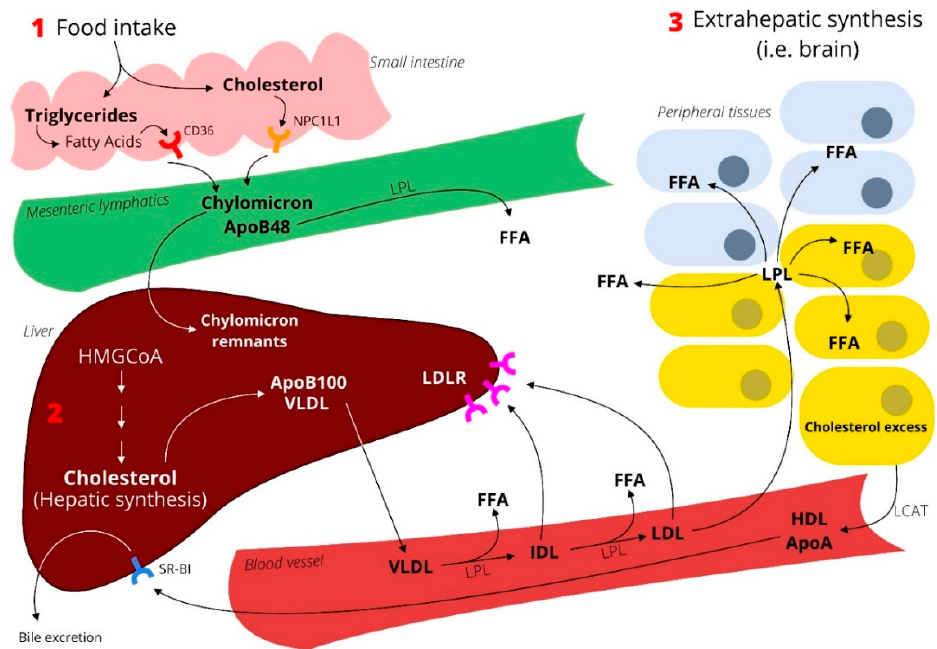
Figure 1. Lipoprotein metabolism. Lipoproteins are classified on the basis of their density as chylomicrons, VLDL, LDL, and HDL. Chylomicrons are low-density lipoproteins that transport dietary lipids from intestinal mucosa to the blood via lymphatic tissue. The associated apolipoproteins include apoA (I, II, IV); apoB48; apoC (I, II, III), and apoE. VLDL transports primarily triglycerides from the liver to the peripheral tissues and its apolipoproteins are apoB100, apoC (I, II; III), and apoE. LDL transports cholesterol esters and its apolipoproteins are apoB100. By contrast, HDL transports cholesterol from the periphery to the liver and it consists of cholesterol esters and its apolipoproteins are apoA (I, II), apoC (I, II, III), and apoE. With respect to the lipoprotein metabolism, after a meal, cholesterol is taken up by the enterocytes via the specific transporter Niemann-Pick C1-Like 1 (NPC1L1). Triglycerides are lipolyzed into free fatty acids (FFA) and taken up either by passive diffusion or by specific transporters such as CD36. Then, cholesterol is esterified by cholesterol acyltransferase and FFA is either re-esterified into triglycerides or released directly into the circulation. Otherwise, cholesterol and triglycerides assemble with apoB48 to form chylomicrons that are released into the circulation. There, they are cleaved by lipoprotein lipase (LPL) into FFA, which is used as an energy source by peripheral tissues. Chylomicron remnants are cleared by liver uptake, through their binding to LDL receptor family members. In parallel, hepatocytes synthesize cholesterol and produce VLDL, which contains triglycerides, cholesterol, and apoB100. VLDL is released into the circulation, where it undergoes lipolysis to release FFA. This becomes LDL and is ultimately cleared away by the hepatic LDL receptor. The reverse cholesterol transport is a process that takes place in the periphery and that is mediated by HDL. Excess cholesterol is transferred to lipid-poor apoAI or to nascent HDL by the specific transporters ATP-binding cassette (ABCA1) and ATP-binding cassette sub-family G member 1 (ABCG1). Next, cholesterol is esterified by lecithin–cholesterol acyltransferase (LCAT). Once HDL is formed, it can directly bind to scavenger receptor class B type 1 (SR-BI) on the liver and transfer cholesterol. Otherwise, cholesteryl esters can be transferred to apoB lipoproteins by cholesteryl ester transfer protein (CEPT), or a small portion of HDL can acquire apoE and bind to LDL receptor.